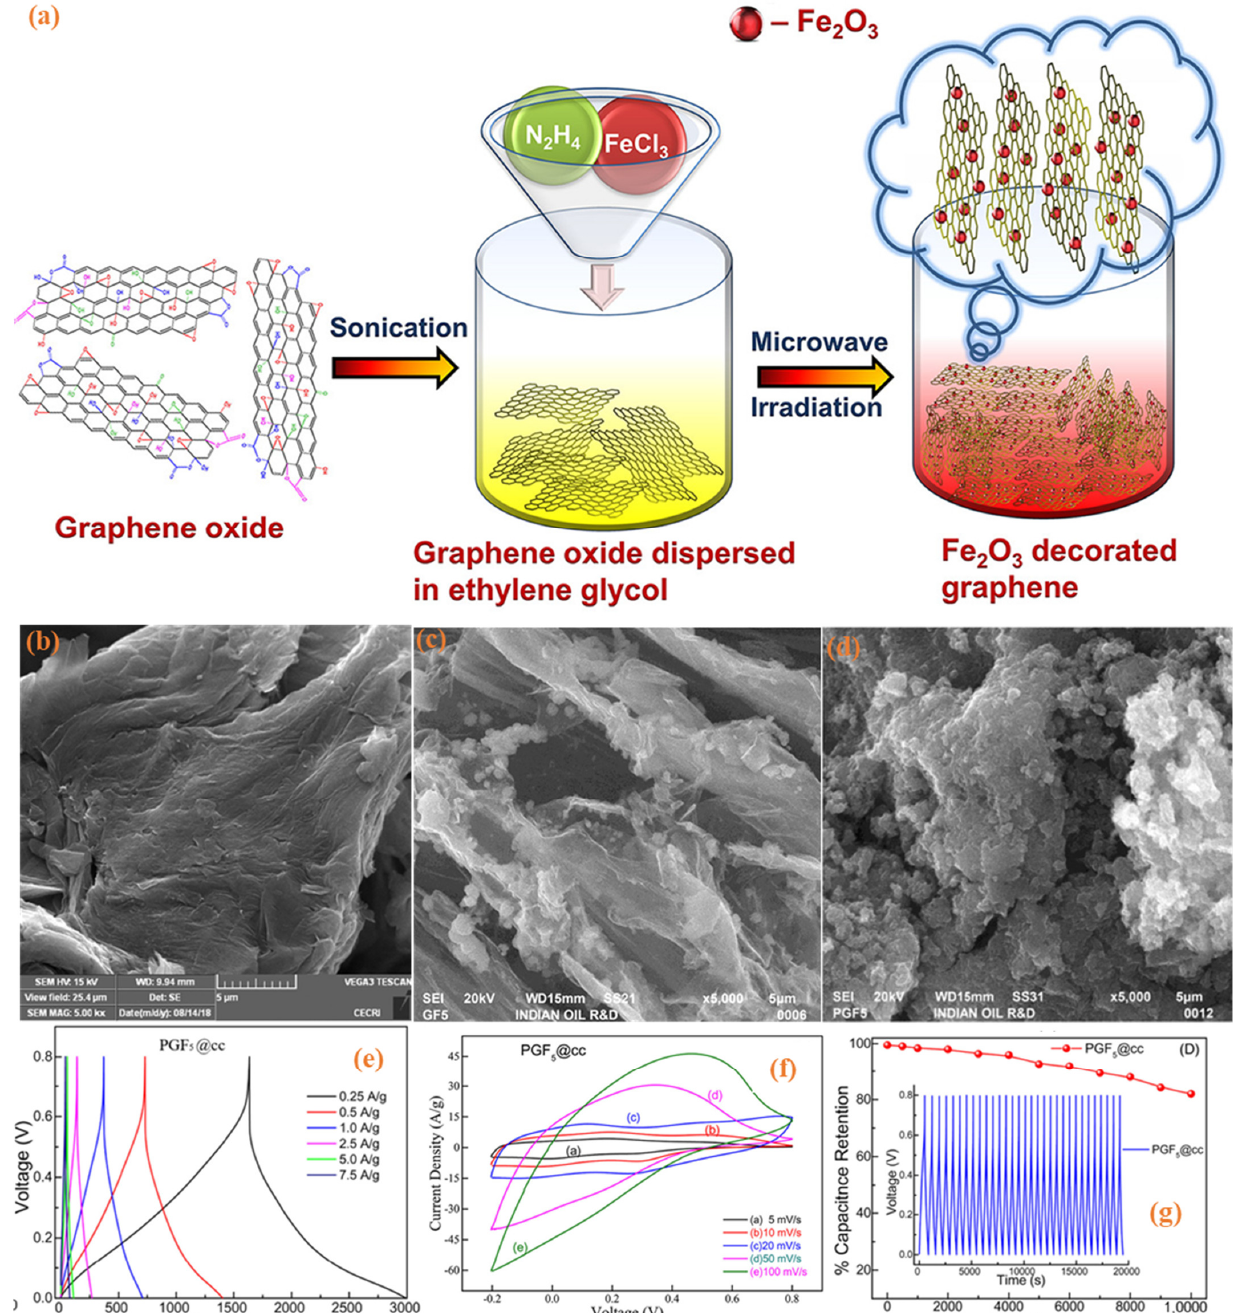
Figure 12. ( a ) The graphical interpretation of the synthesis of Fe 2 O 3 - decorated graphene